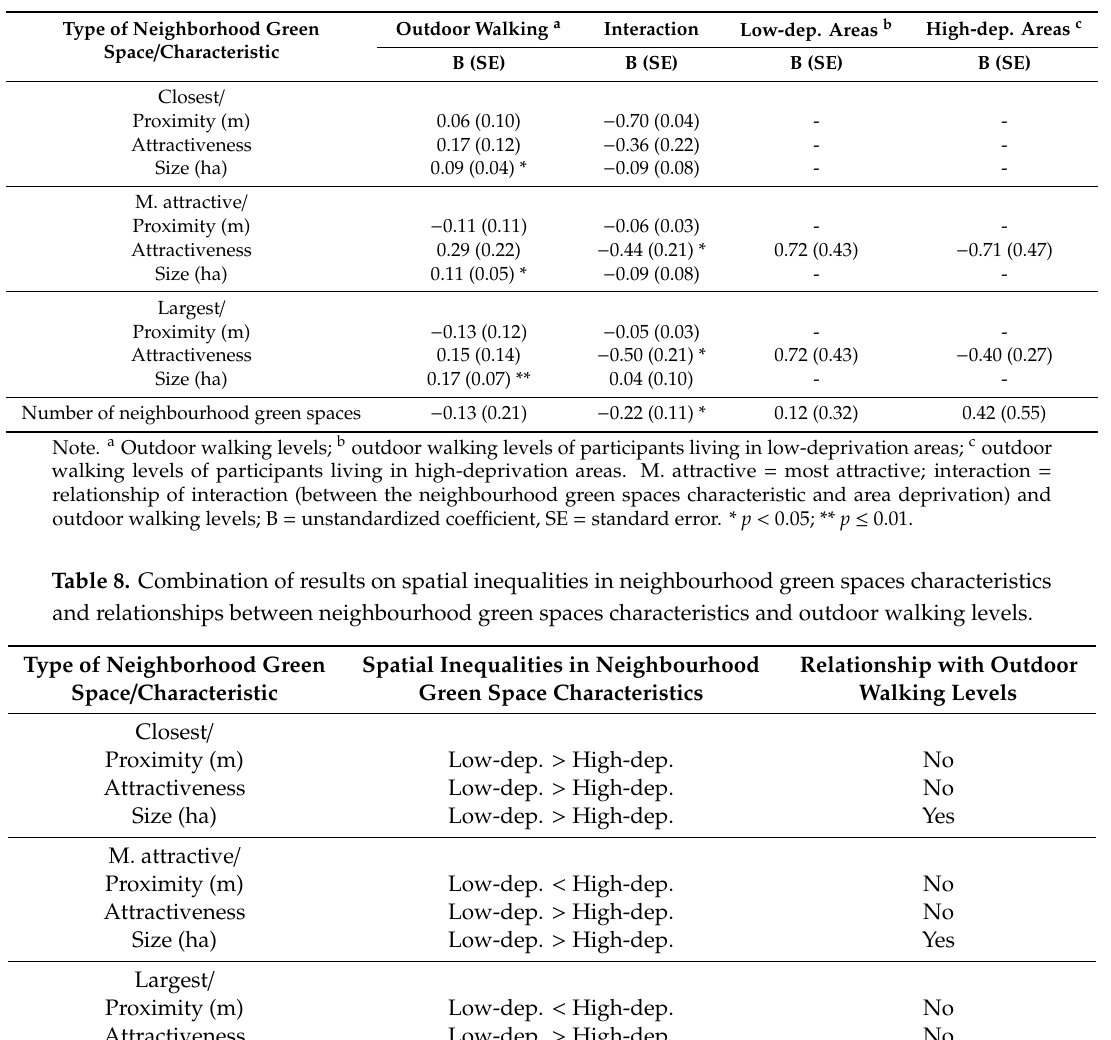
Table 7. Results of hierarchical regression: relationships between characteristics of three types of neighbourhood green spaces (the closest, most attractive, largest) and outdoor walking levels.